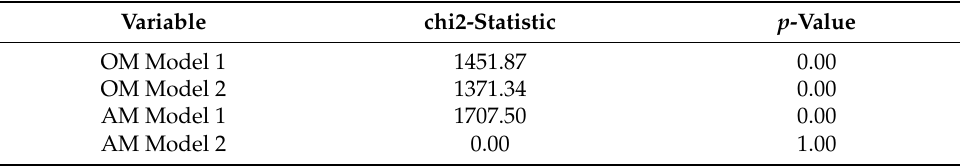
Table A7. Breusch-Pagan LM test for random effects.